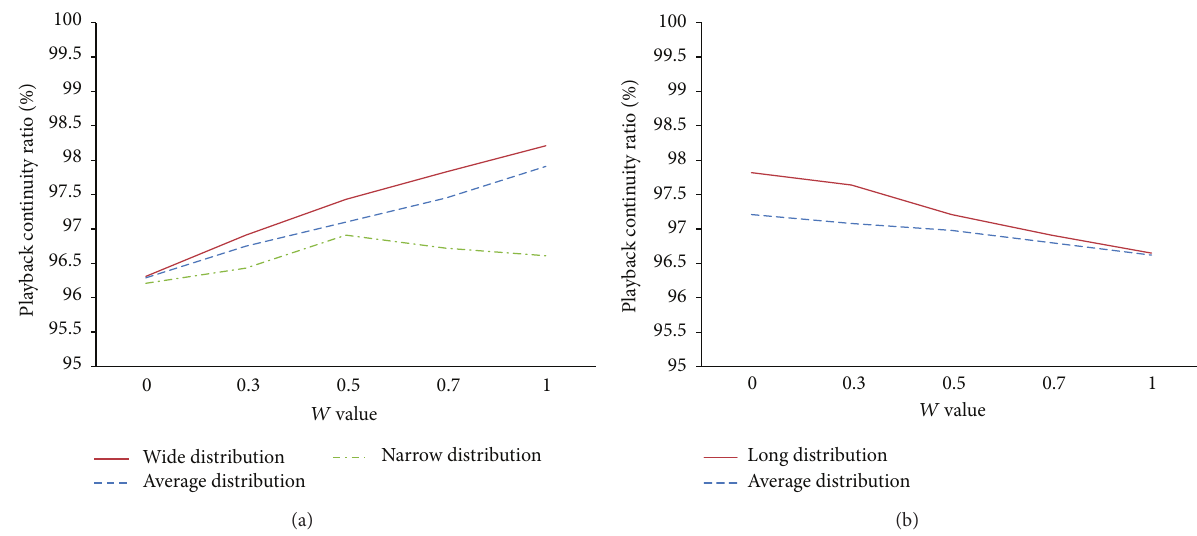
Figure 4: Impact of two criteria for agent peer selection on the playback continuity ratio: (a) RTT values and (b) lengths of average buffering